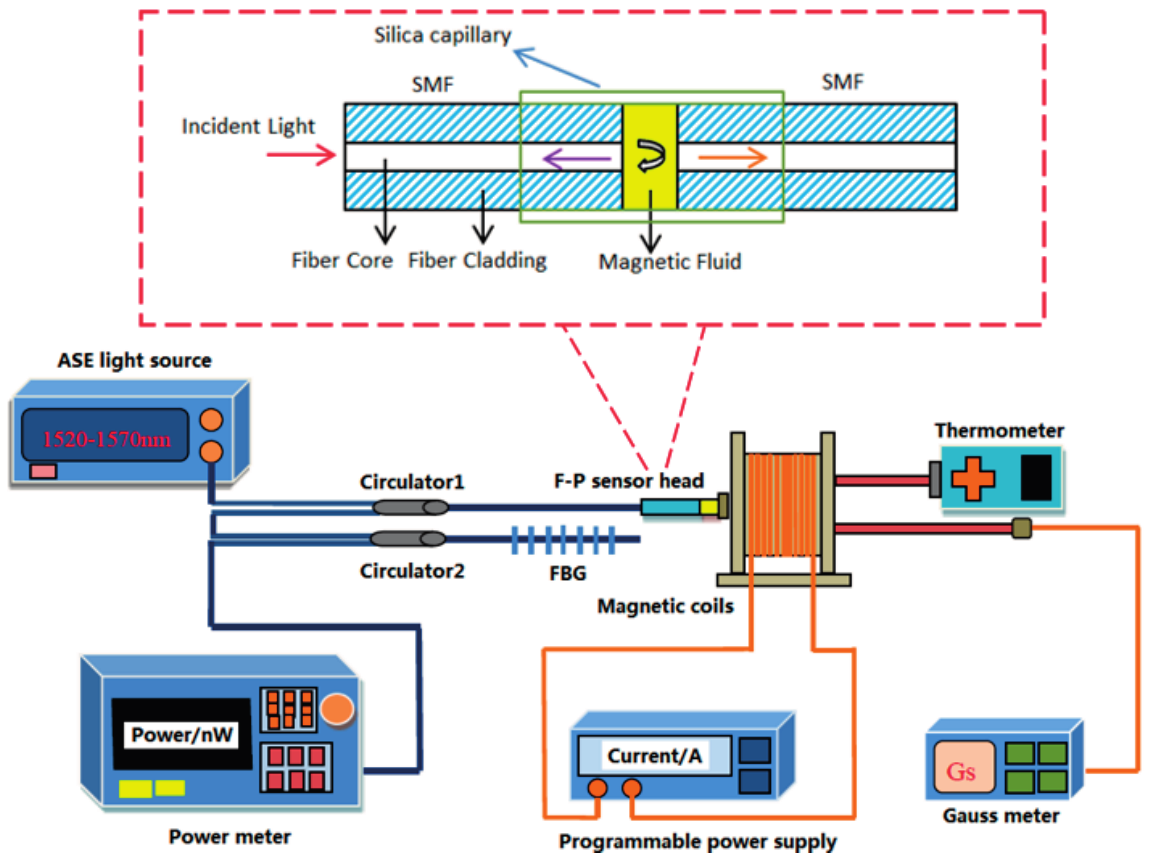
Figure 1. Experimental setup of current sensing system based on the Fabry-Perot (F-P)